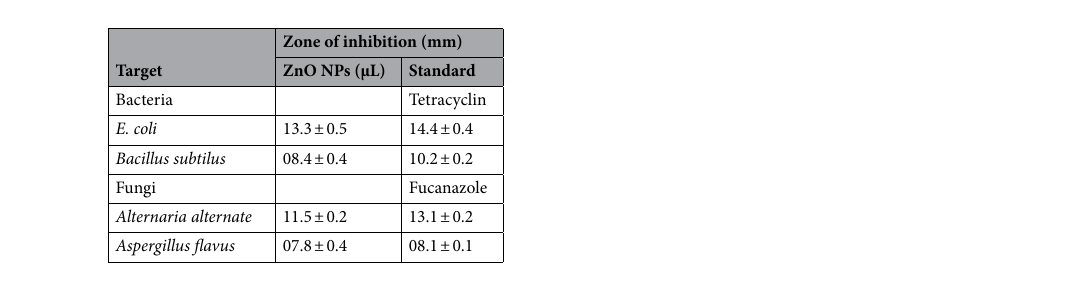
Table 5. Zone of inhibition (mm) by Lawsonia inermis mediated ZnO NPs against bacteria and